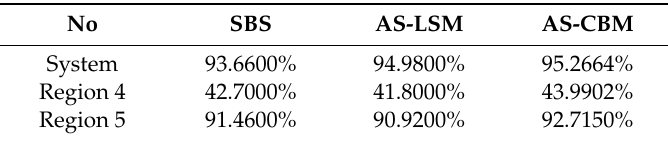
Table 6. The absolute error of probabilities for the system, region 4, and region 5 RoCoF by AS-LSM and AS-CBM within operational limits (correlated wind speed).